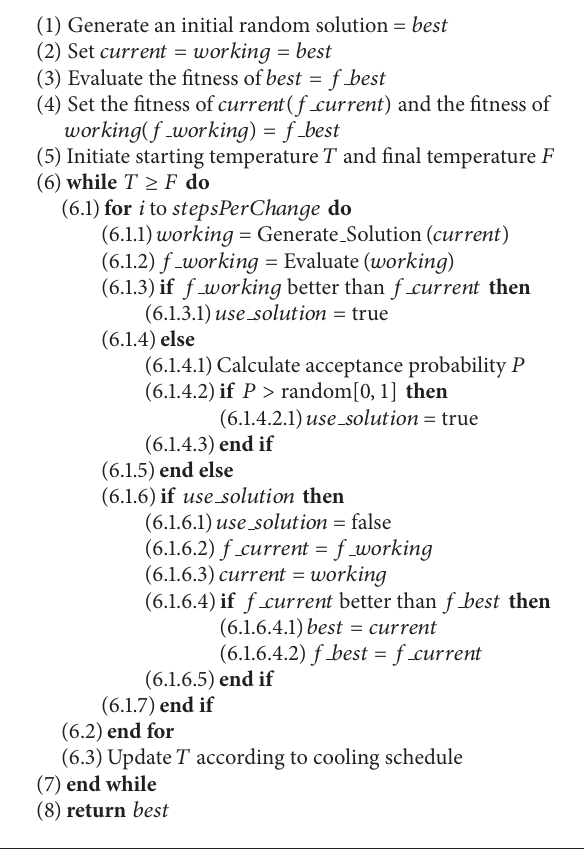
Table 2: Lower and upper bounds for each plot type. Plot types Single crop 10 1,700 Double crop 50 1,740